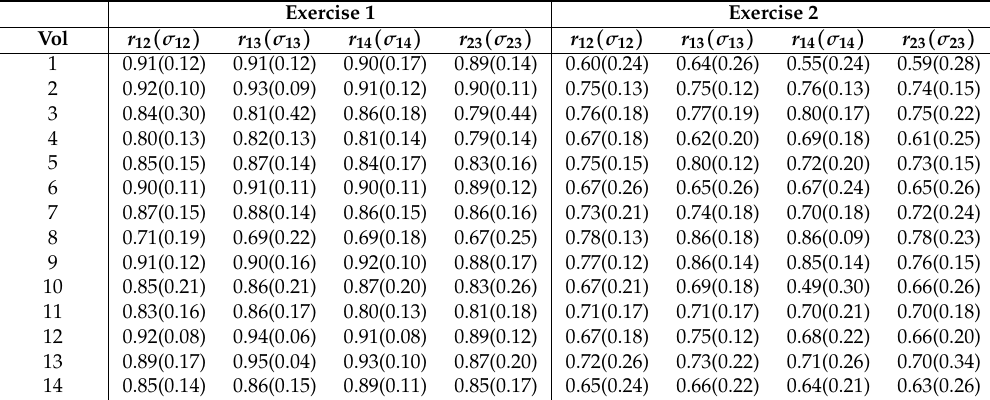
Table 8. r calculated between the sensor 1 and sensors 2, 3 and 4; and between sensors 2 and 3, during exercises 1 and 2. Columns in this table provide the same information shown in Table 7, but in this case for exercises 1 and